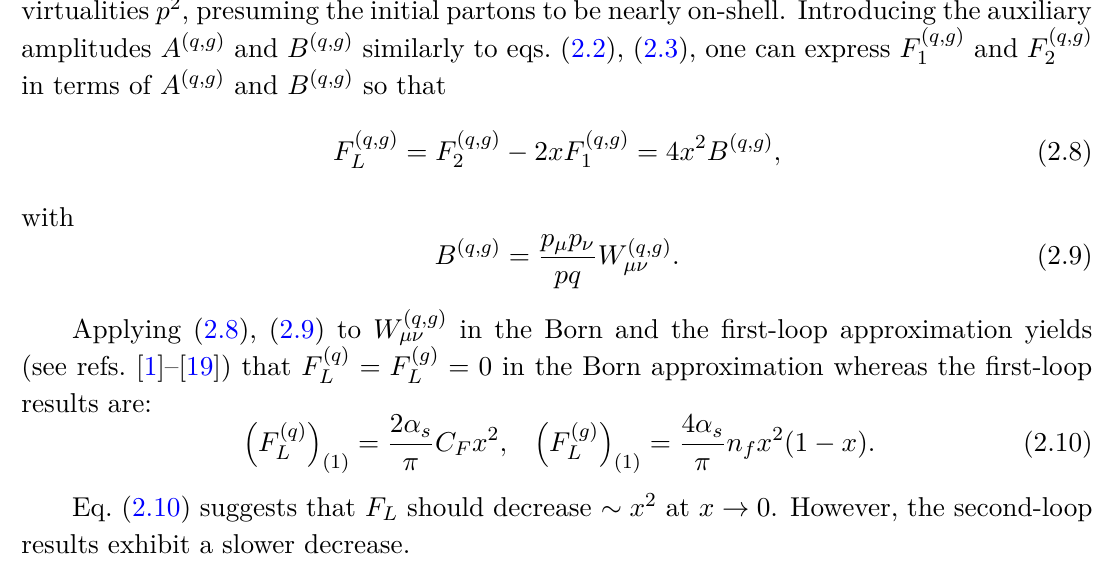
, F ( q,g ) and F ( q,g ) 1 2 L